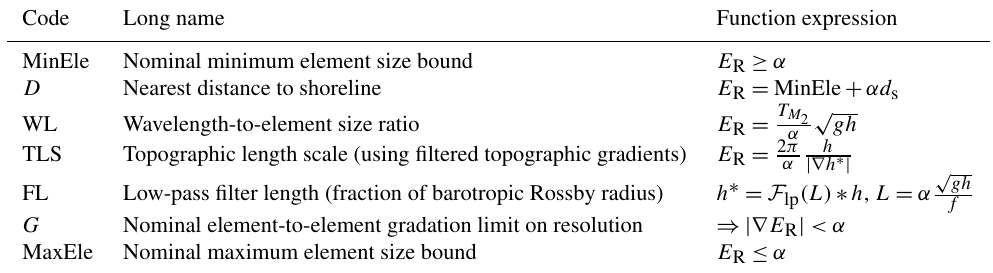
Table 1. The mesh size functions used to spatially distribute element resolution, E R . The variable parameter in each function is indicated by α . Code Long name Function expression MinEle Nominal minimum element size bound E R ≥ α D Nearest distance to shoreline Wavelength-to-element size